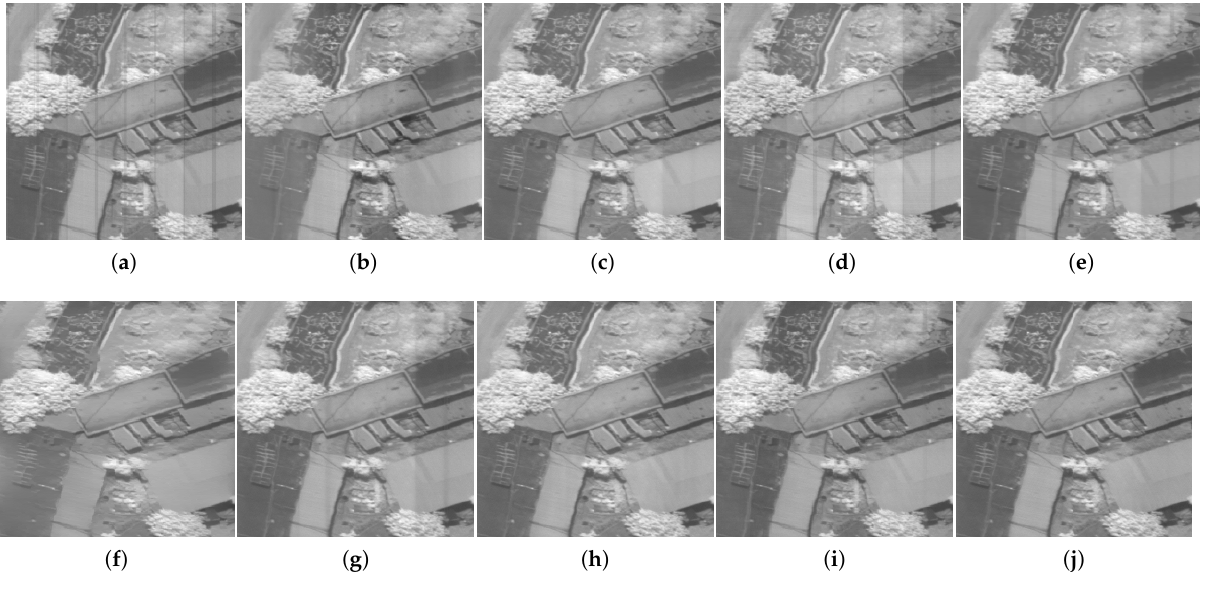
Figure 8. Corrected VNIR images for band 64. ( a ) VNIR image. Images corrected by ( b ) MM, ( c ) AS- STV, ( d ) LRSID, ( e ) the method of [43], ( f ) PADMM, ( g ) ICSRN, ( h ) SSGN, ( i ) TSWEU, ( j )